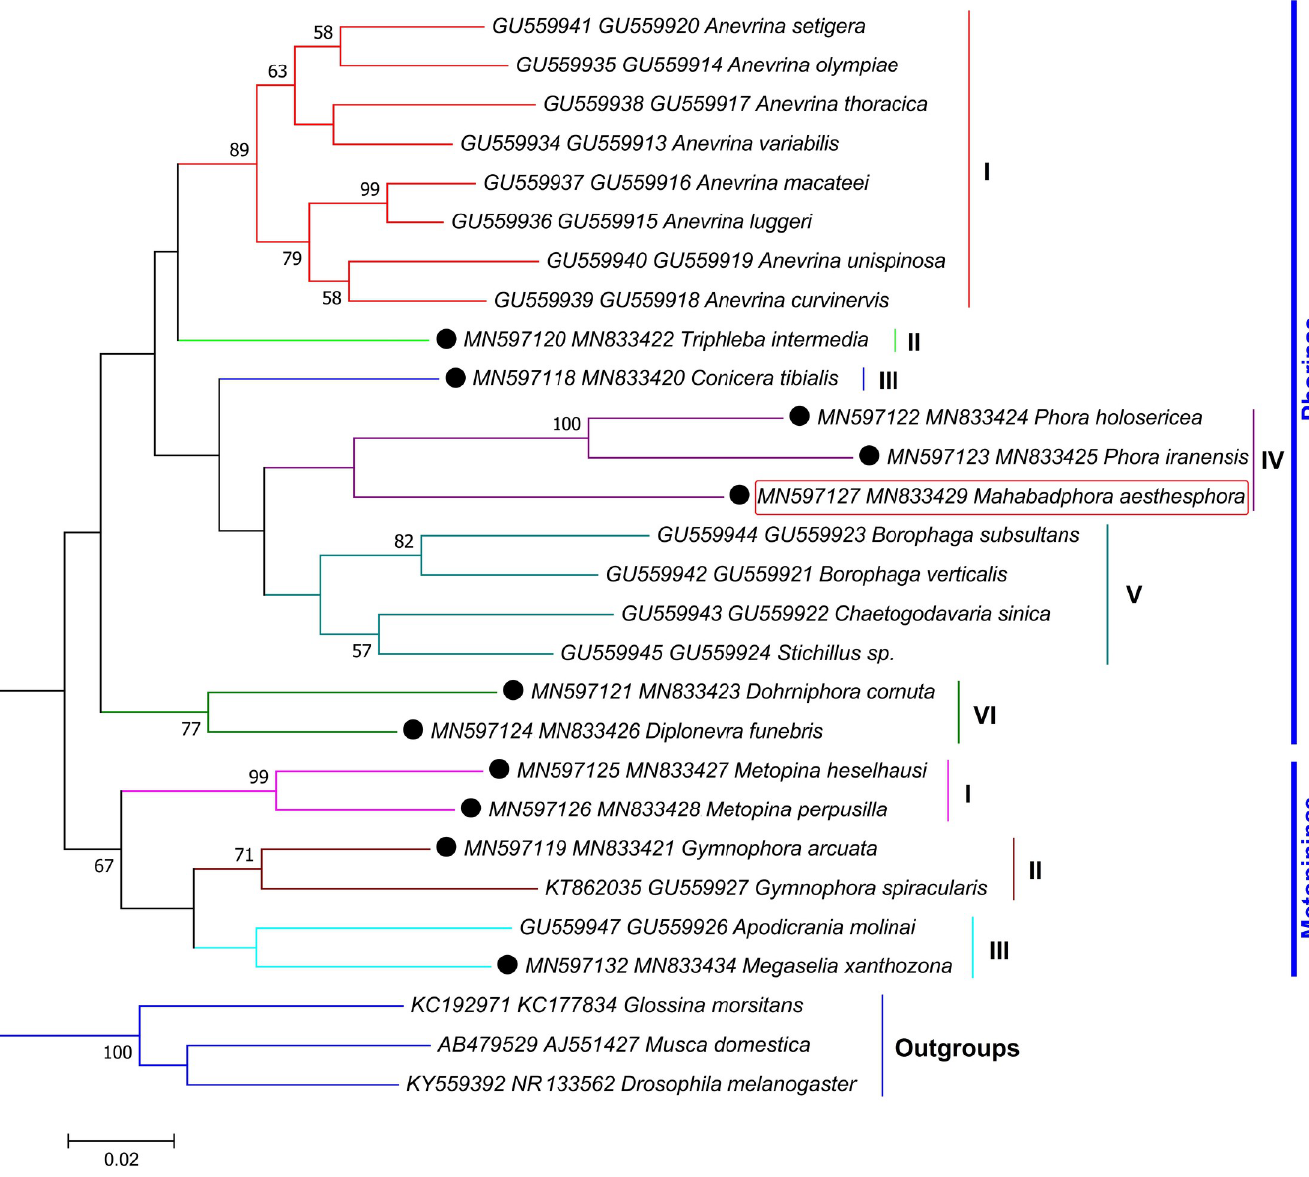
Fig 5. Maximum likelihood tree inferred from 1200–1269 bp of the COI - 28S gene sequences of 11 non- Megaselia species obtained in this study. Only bootstrap values higher than 50% are shown on the branches. The bar indicates substitutions per site. The Drosophila melanogaster (Meigen, 1830) (KY559392 and NR_133562), Glossina morsitans Westwood, 1851 (KC192971 - KC177834) and Musca domestica Linnaeus, 1758 (AB479529 - AJ551427) were set as outgroups. https://doi.org/10.1371/journal.pone.0257899.g005 PLOS ONE | https://doi.org/10.1371/journal.pone.0257899 October 13,